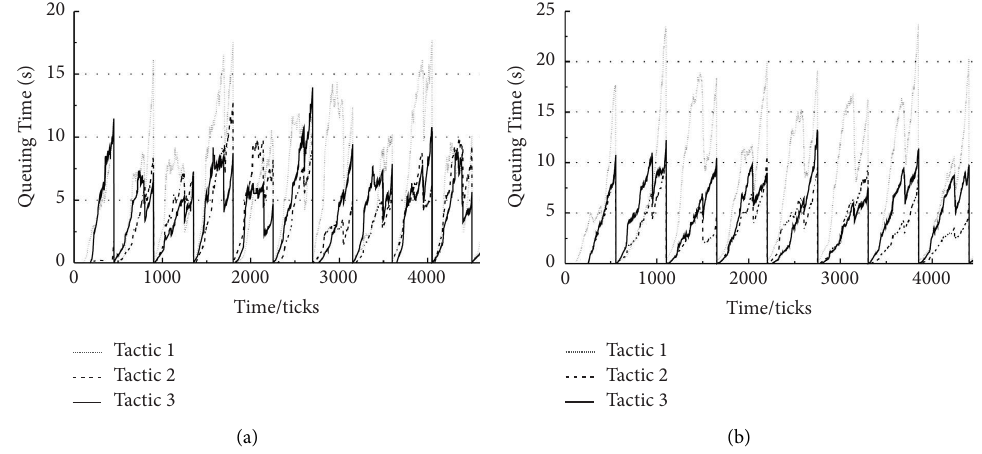
Figure 9: Comparison chart of queuing time with diferent control tactics: (a) queuing time during of-peak hours and (b) queuing time during peak hours.